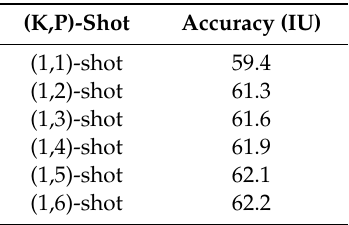
Table 2. Our method is strangely insensitive to the amount of annotations in semantic segmentation. It improves the accuracy of IU (%) very little.